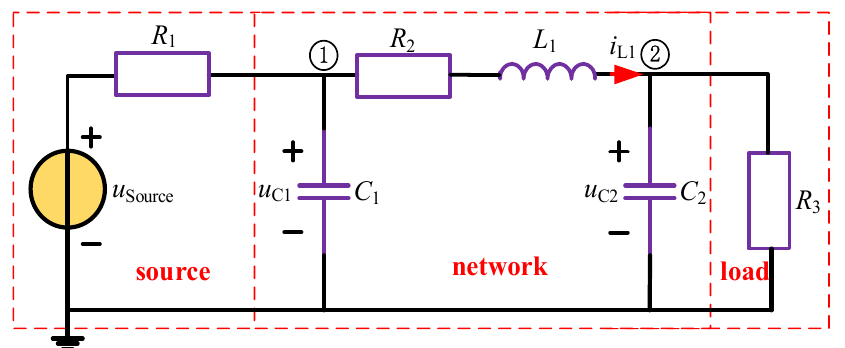
Figure 13. A simplified transmission system diagram.